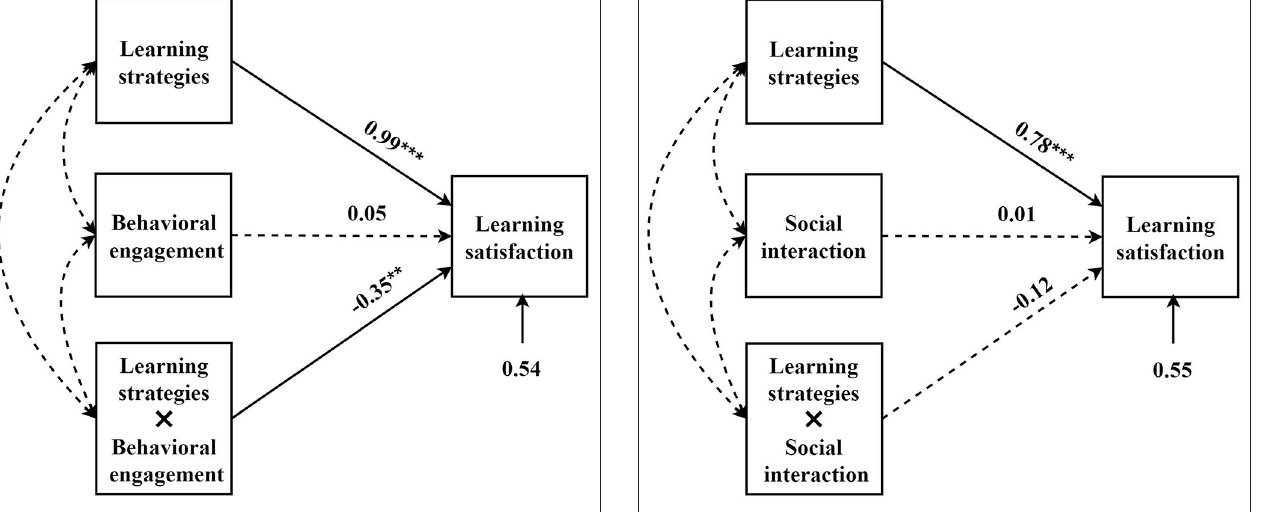
FIGURE 4 | The influence of learning strategies on learning satisfaction: a moderating model of social interaction. *** p < 0.001.